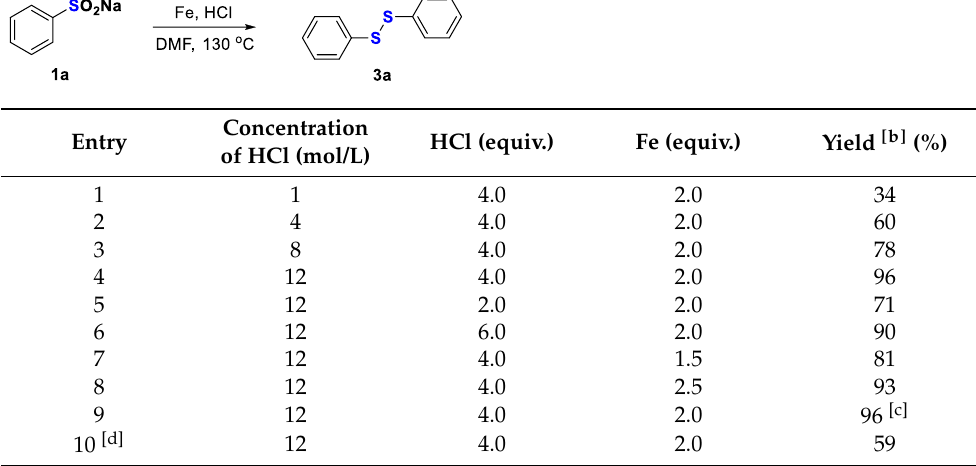
Table 4. Scope of sodium arylsulfinates to diaryl disulfides [a,b]